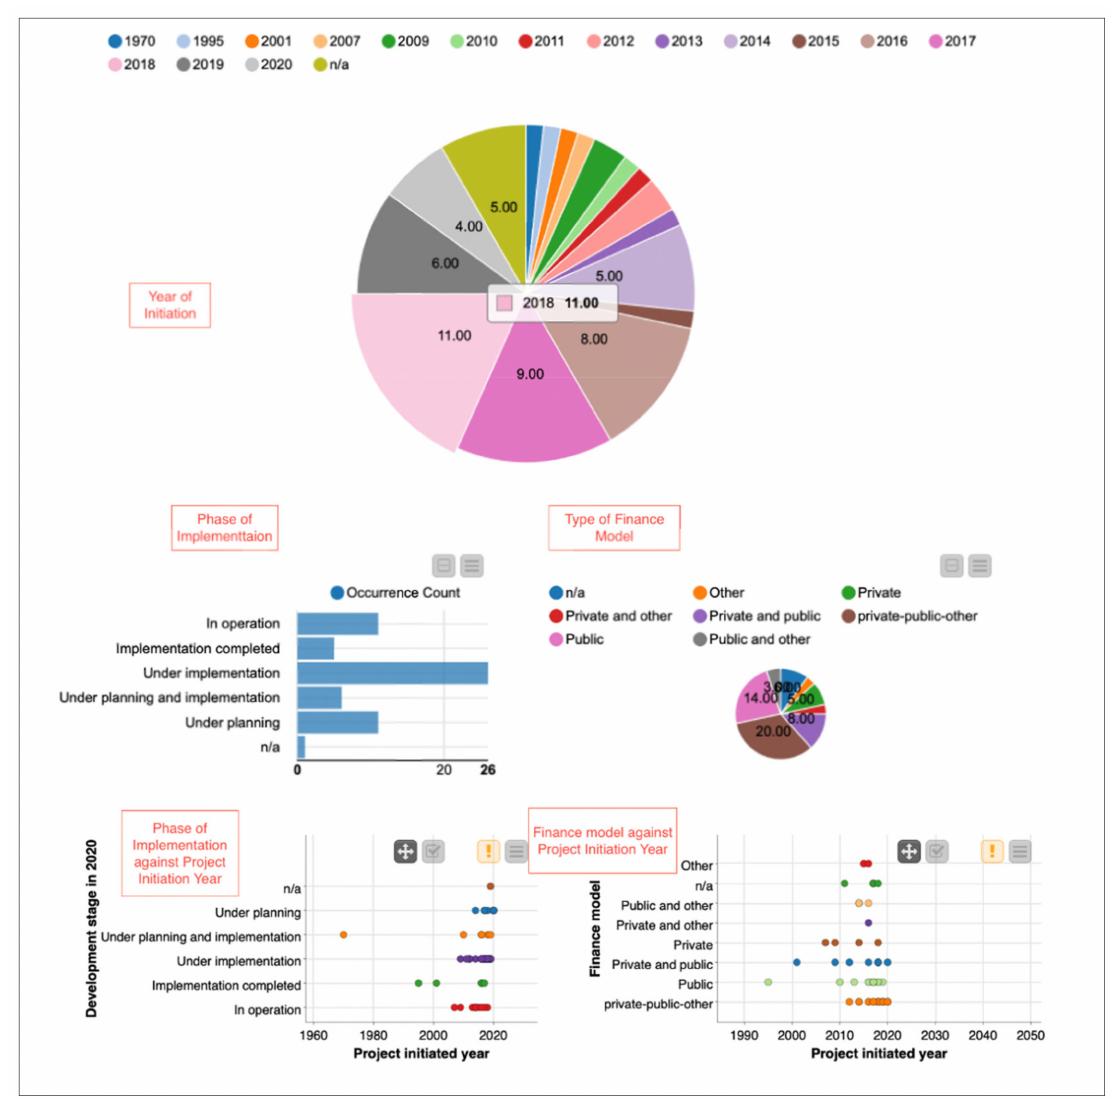
Figure 11. Interactive Knime